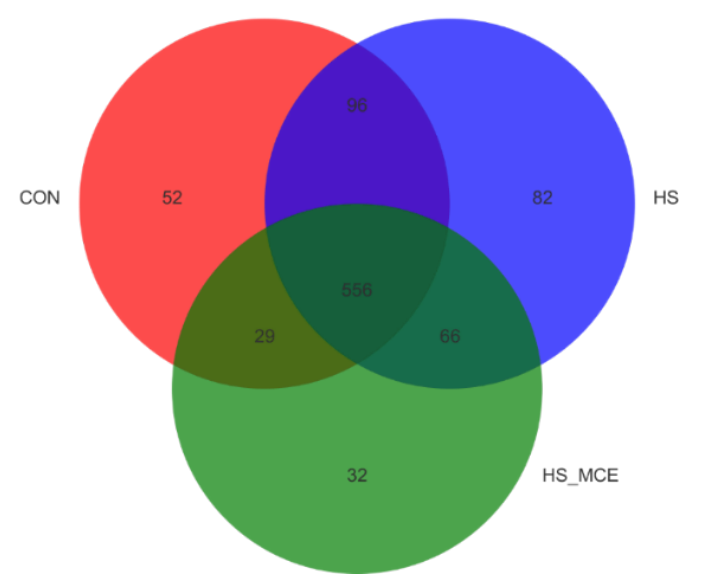
Figure 1. Effects of MCE on the number of cecal bacterial OTUs. The Venn diagram represents the number of shared and unique OTUs for the three groups, CON for the Control group, HS for the Heat Stress group, and HS-MCE for the Heat Stress plus Macleaya cordata extract group.